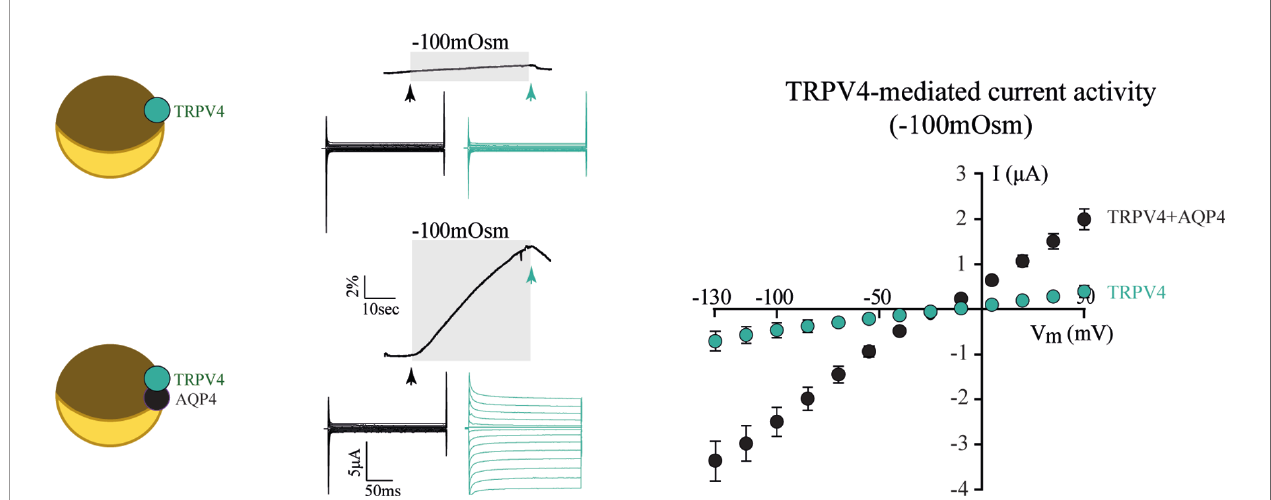
FIGURE 2 | TRPV4 is activated by increased cell volume. Oocytes expressing TRPV4 alone (top traces) did not swell when exposed to a hyposmotic gradient (-100 mOsm) and did not respond with TRPV4-mediated currents during this challenge. Oocytes co-expressing TRPV4 and AQP4 (bottom traces) responded to the osmotic challenge with an abrupt volume increase and a resultant large membrane current (summarized in right panel). Modi fi ed from (32) with